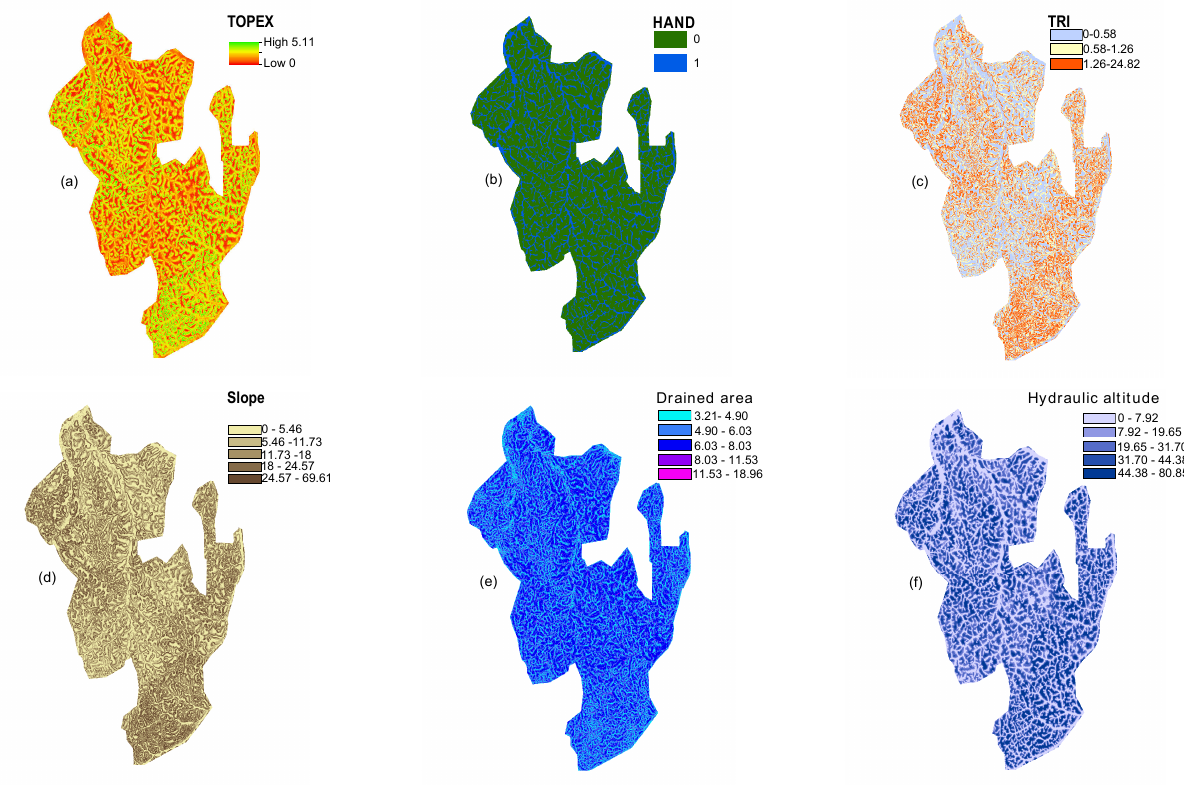
Figure 2. Spatial distribution of the six environmental variables used to (i) test association and (ii) map canopy height in Regina forest: ( a ) TOPEX; ( b ) HAND; ( c ) TRI; ( d ) Slope; ( e ) Da; and ( f ) Hydraulic